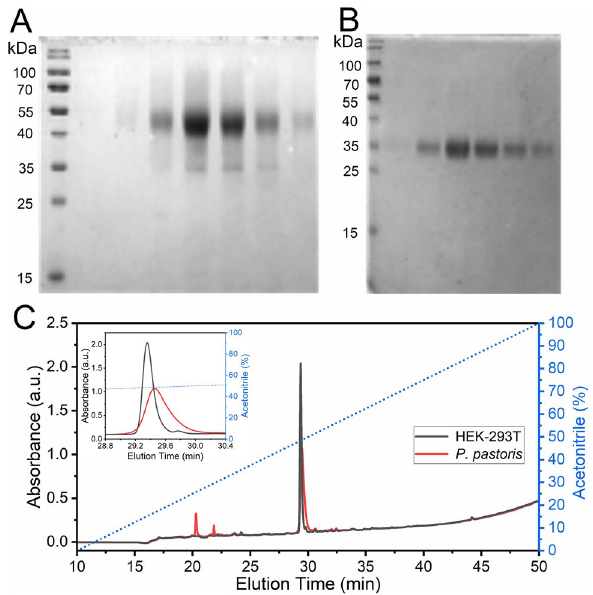
Figure 2. Analysis by SDS-PAGE and Reverse Phase (RP)-HPLC of RBD produced in P. pastoris or HEK- 293T, and purified by NTA-Ni 2+ . Analysis of recombinant RBD fractions eluted from a NTA-Ni 2+ column by 300 mM imidazole after purification from supernatants of a P. pastoris culture ( A ) or of HEK-293T cells ( B ). ( C ) RP-HPLC Analysis of RBD. Profiles for RBD produced in P. pastoris (red) and HEK-293T mammalian cells (black). The inset shows the expanded region of the chromatogram where the highest peaks eluted. The dashed blue line indicates the variation of acetonitrile (% v/v) during the experiments. Peaks 1, 2 and 3 from RBD produced in P. pastoris correspond to areas of 10.1, 2.8 and 87.1%,